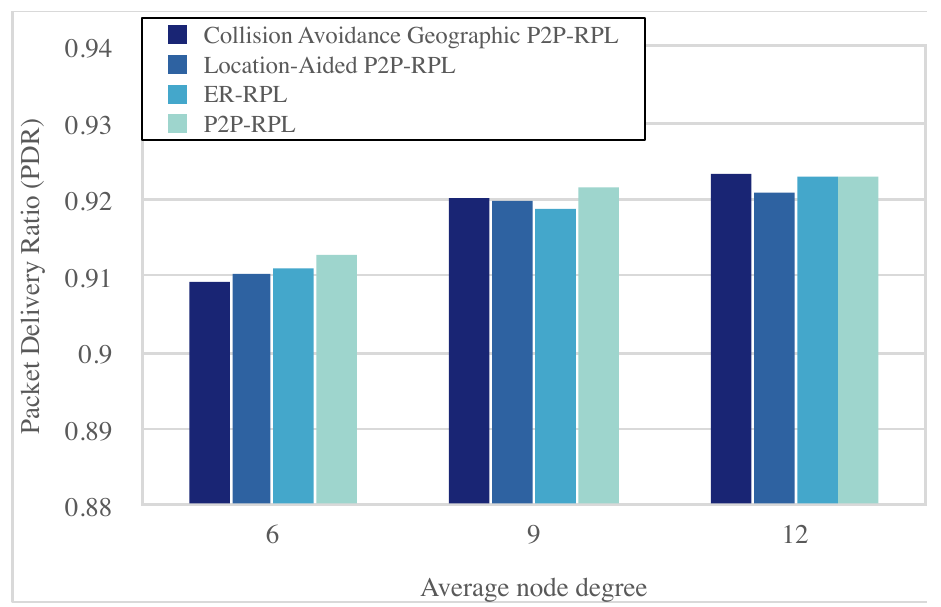
Figure 11. The packet delivery ratio versus the average node degree.